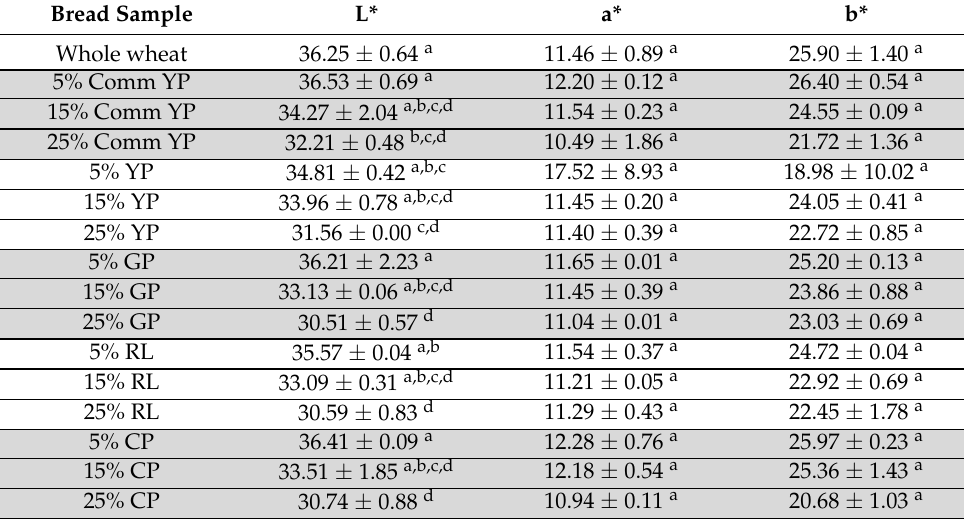
Table 5. Color parameters of whole wheat/pulse bread crumb.